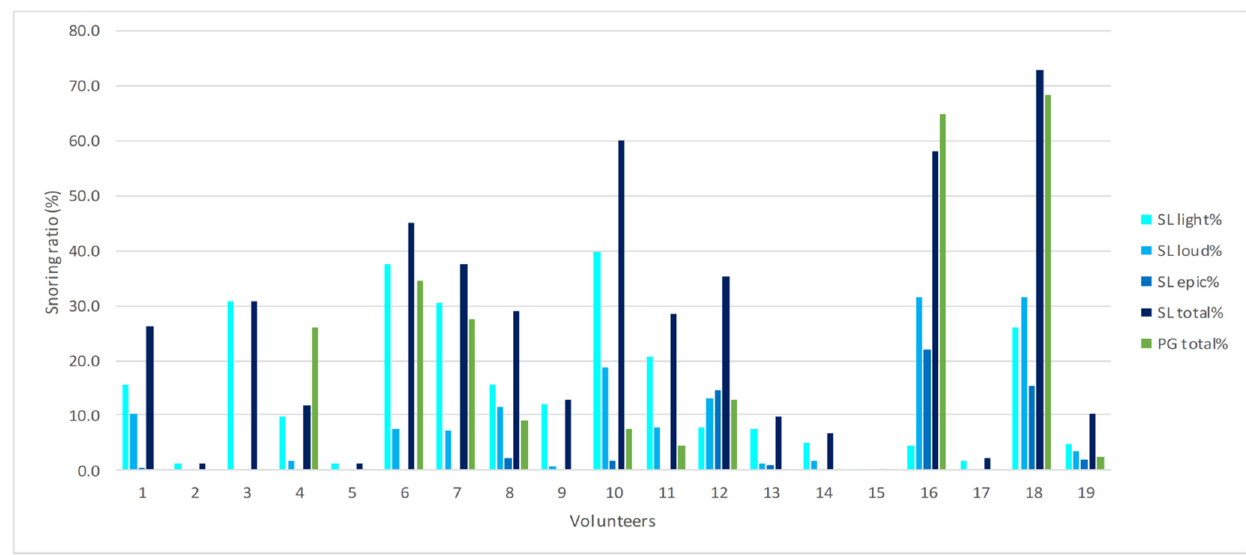
Figure 1. Individual percentage of snoring (%) measured by the SnoreLab app (SL) and polygraphy (PG) given for all 19 volunteers.